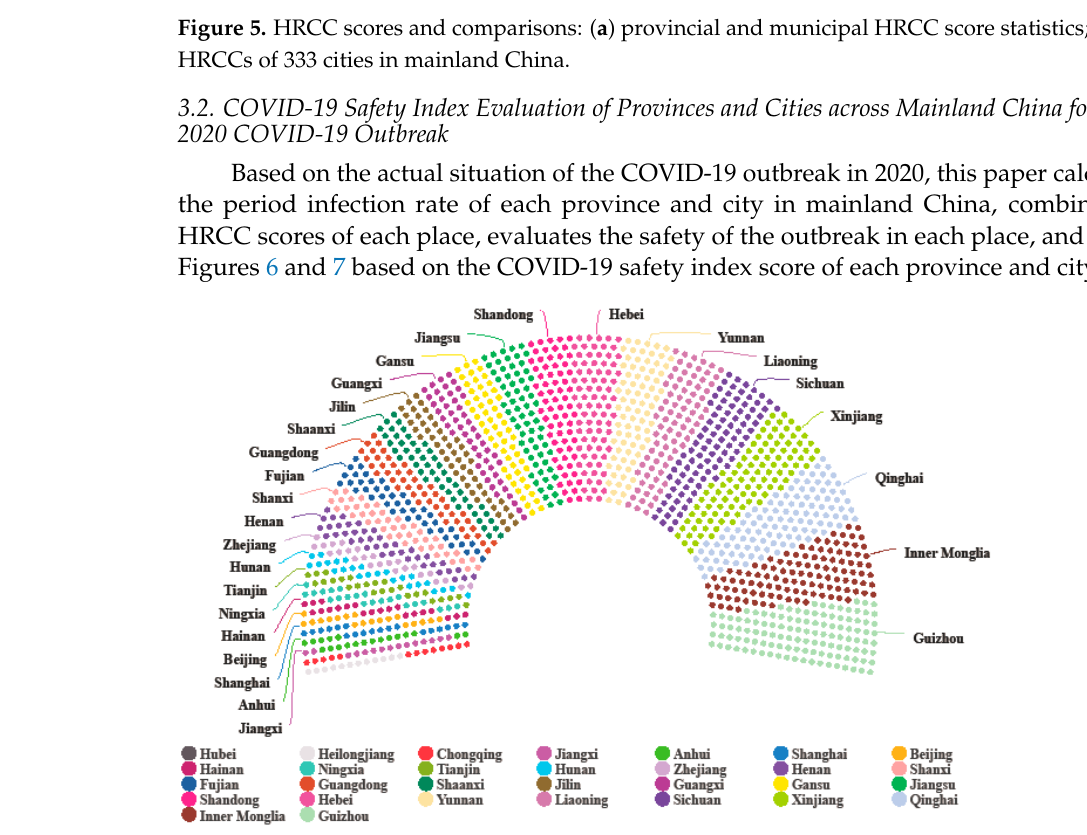
Figure 6. Distribution of the “COVID-19 safety index” scores in 333 cities in mainland China (an extreme value was excluded because there was only one case in Tibet, resulting in a high safety index).